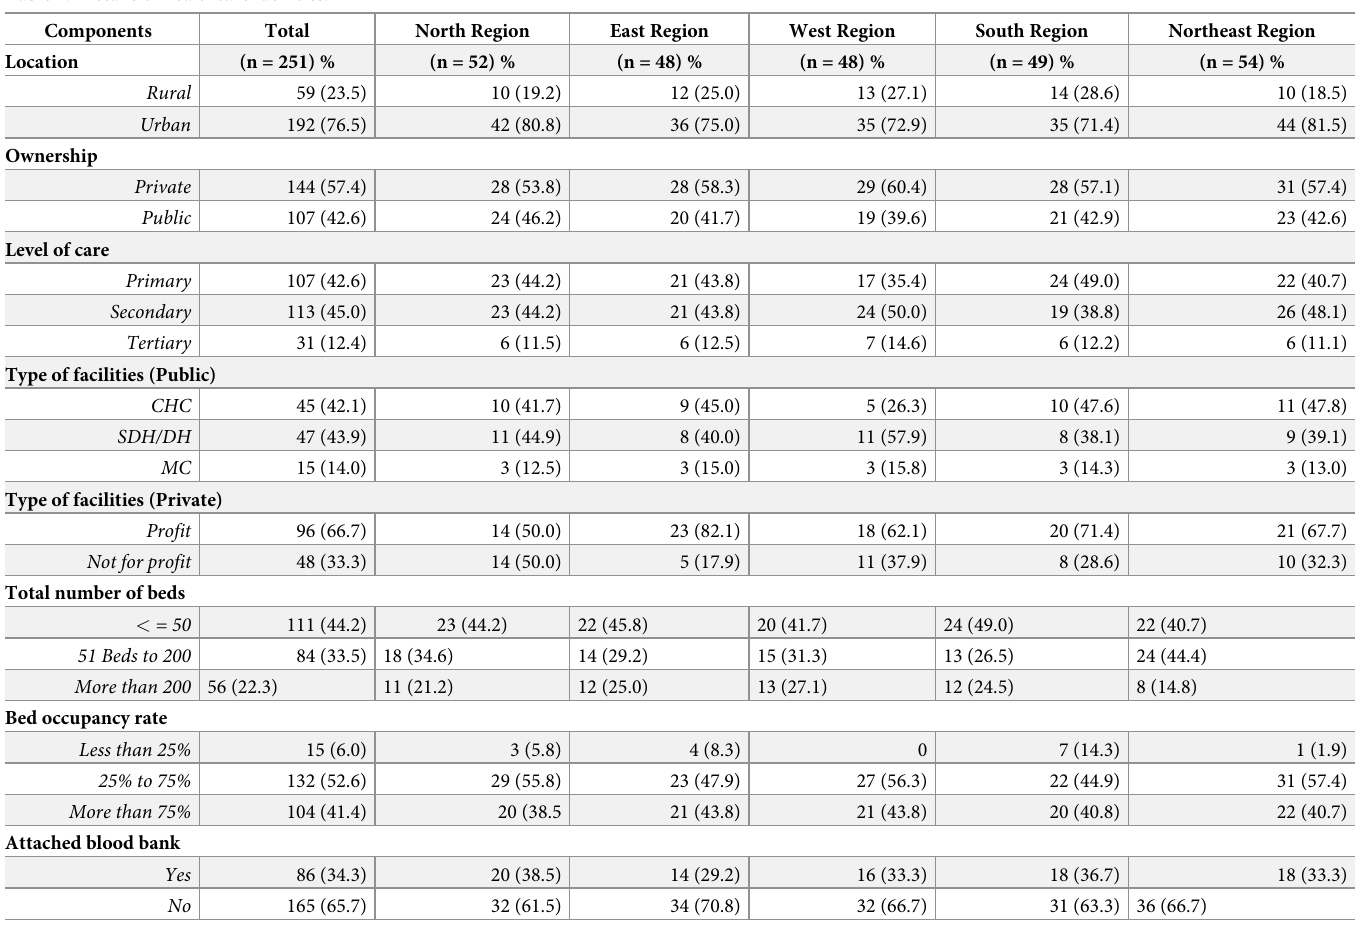
Table 1. Details of healthcare facilities.